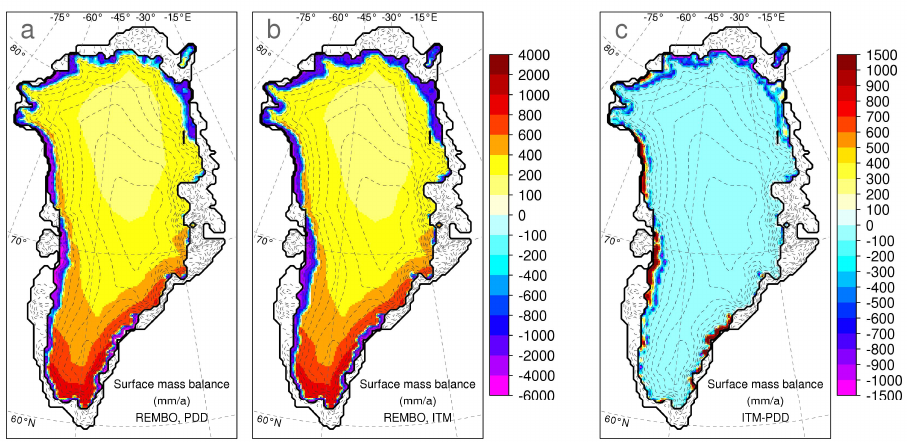
Fig. 5. Diagnosed surface mass balance for fixed, present-day topography using REMBO with ablation determined by (a) PDD and (b) ITM. Panel (c) shows the difference between the two. Elevation contours are shown at 300 m intervals.